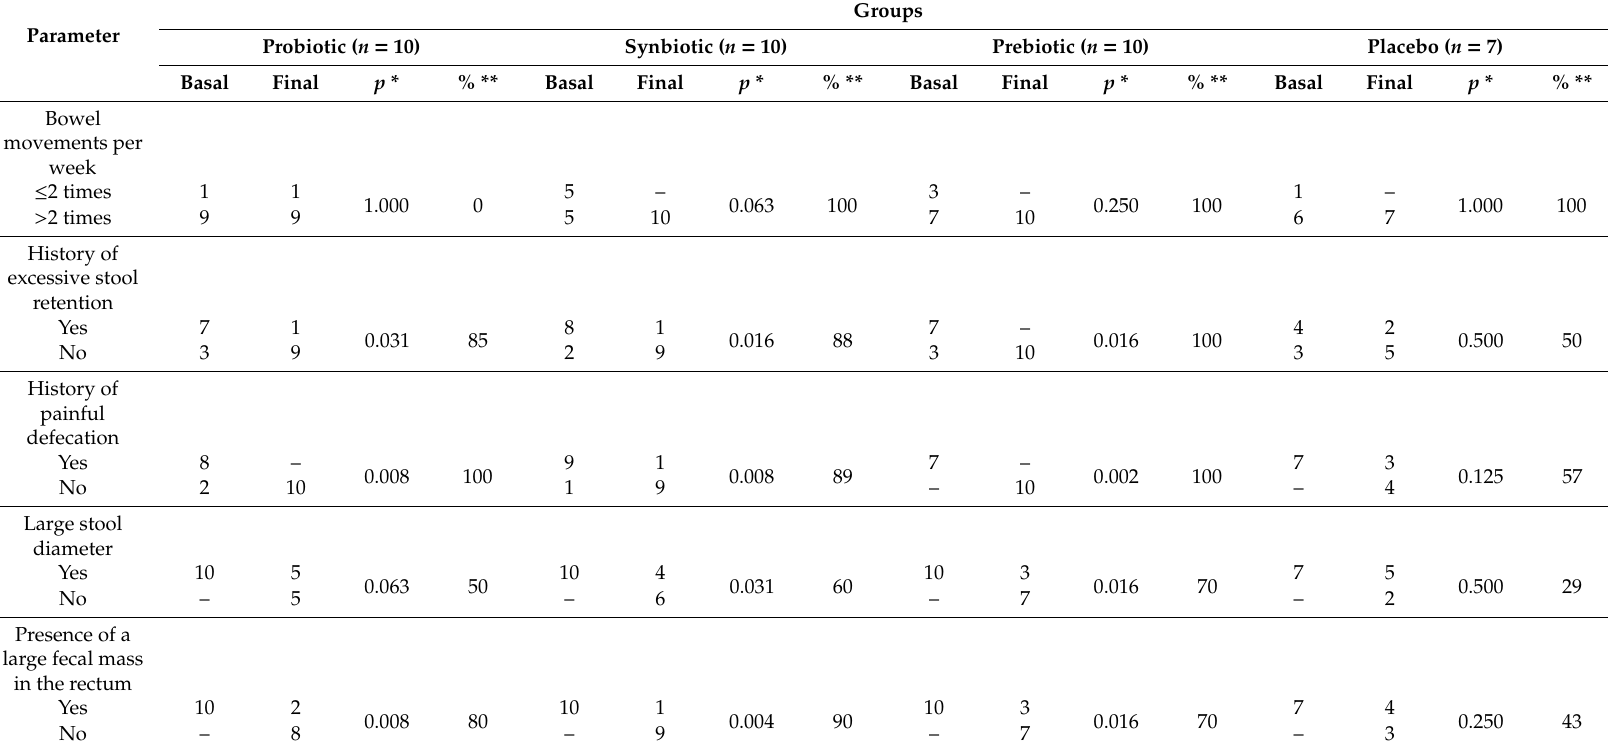
Table 2. Roma IV criteria for constipation (basal vs. final weeks by